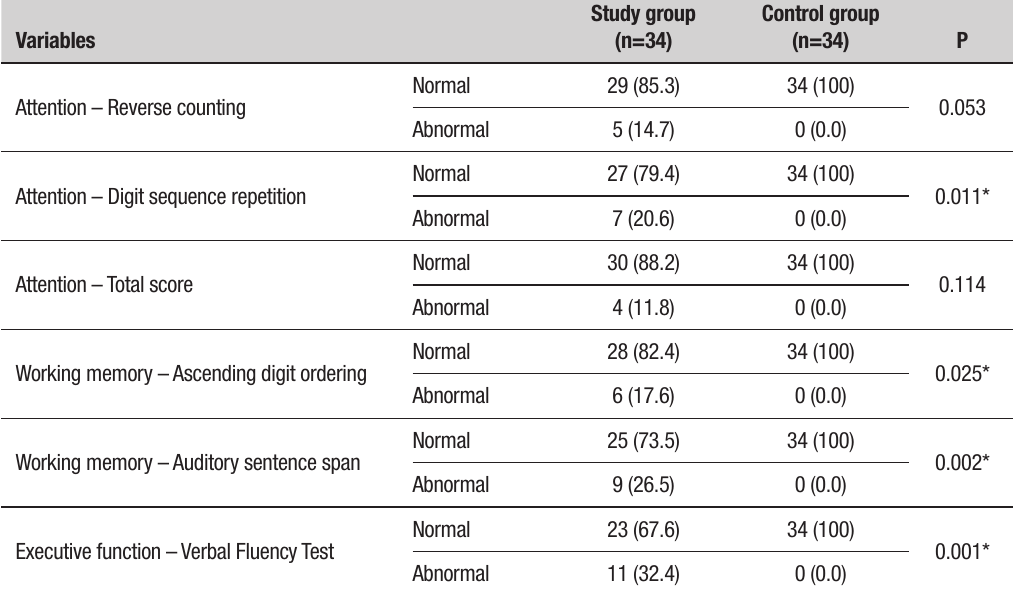
Table 2. Neuropsychological test results.